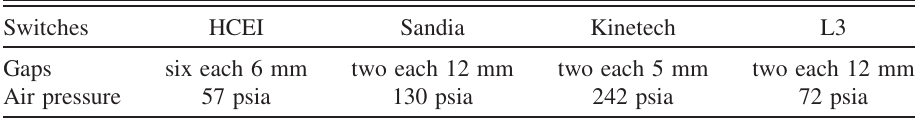
TABLE I. Gas switch physical